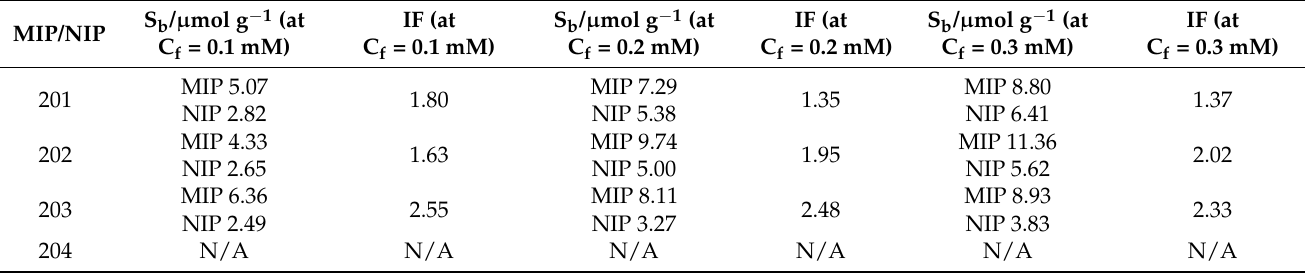
Table 2. Binding capacities (S b ) for MIP 201, 202, 203, and 204 at C f = 0.1, 0.2, and 0.3 mM, and their corresponding imprint factors (IF). Values were drawn directly from the fitted curve of each MIP/NIP at the defined concentration. S b / µ mol g − 1 (at MIP/NIP C f = 0.1